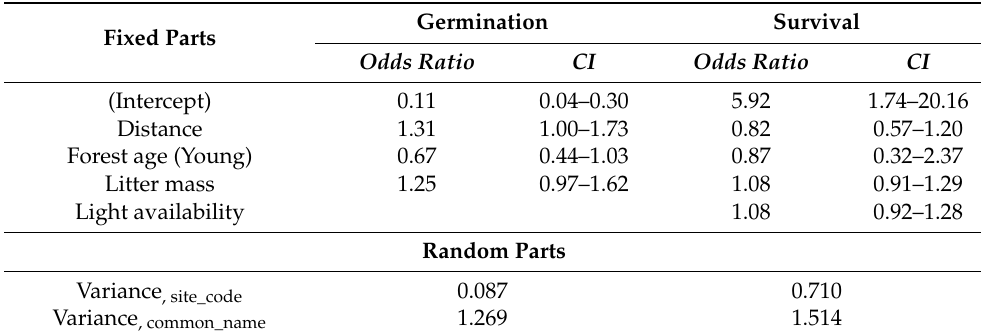
Table A3. Results from generalized linear mixed effects models of germination and survival. Odds ratios and 95% confidence intervals ( CI ) are reported using the scaled predictor variables.